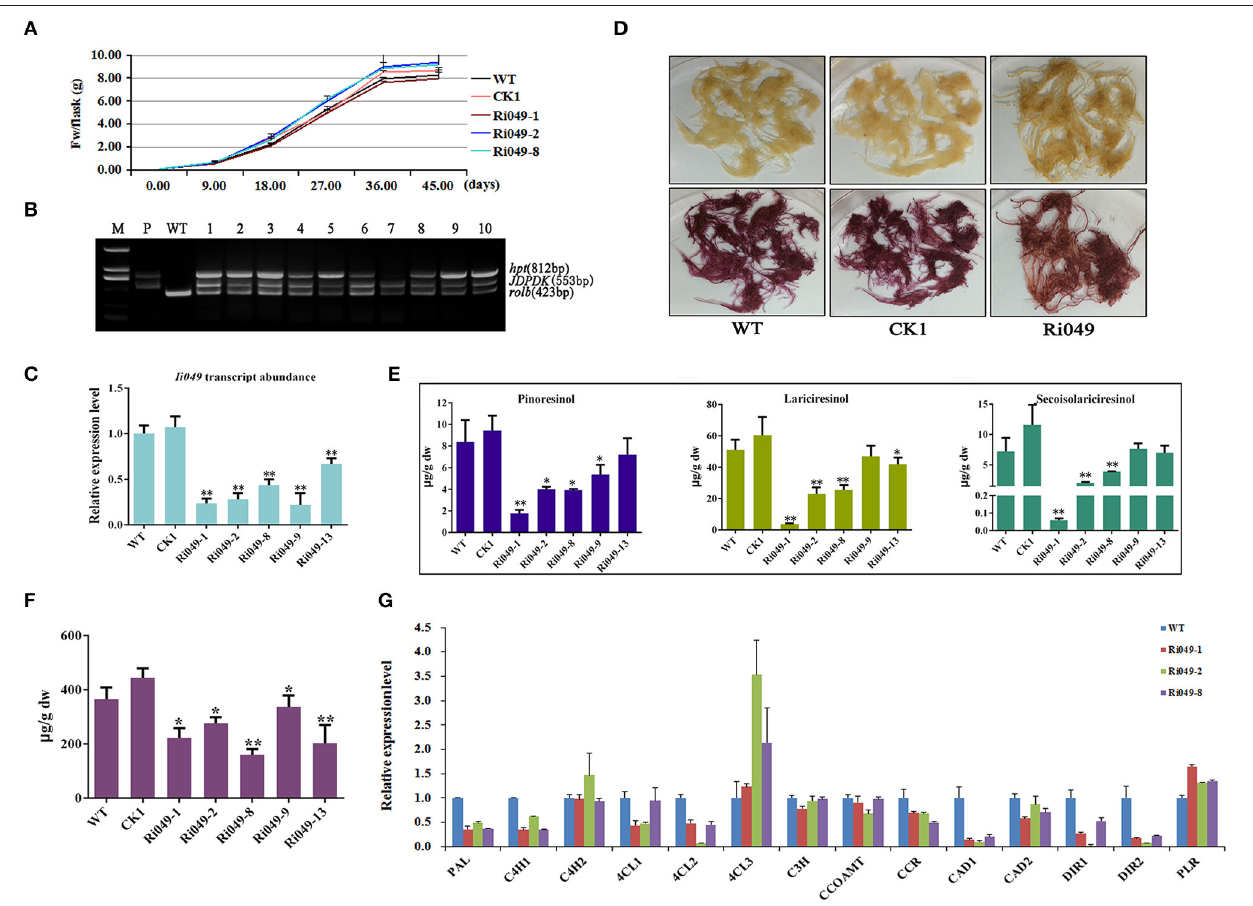
FIGURE 5 | Characterization of transgenic hairy roots silencing Ii0 49. (A) Time course of biomass accumulation of hairy root lines WT, CK1, Ri049-1, Ri049-2, and Ri049-8. (B) Representative PCR analyses for the rolb and hpt genes and the specific gene in transgenic hairy root lines. M, DL-2000 Marker; P, the corresponding engineered bacteria (positive control); and WT, the wild-type hairy root (negative control). (C) Ii049 transcript levels. Bars indicate standard deviation. The level of significance obtained using the Student t -test is marked by the following: * P < 0.05, ** P < 0.01. (D) The phenotype of Ri049 lines before (upper) and after (lower) phloroglucinol-HCl staining. (E) HPLC-MS/MS analysis of pinoresinol, lariciresinol and secoisolariciresinol of different Ri049 lines. (F) SA content in Ri049 lines. (G) Relative expression of lignan/lignin biosynthetic genes in hairy root lines WT, Ri049-1, Ri049-2, and Ri049-8. Each data point is the average of three biological replicates. Bars indicate standard deviation. The level of significance obtained using the Student t -test is marked by the following: * P < 0.05, ** P <